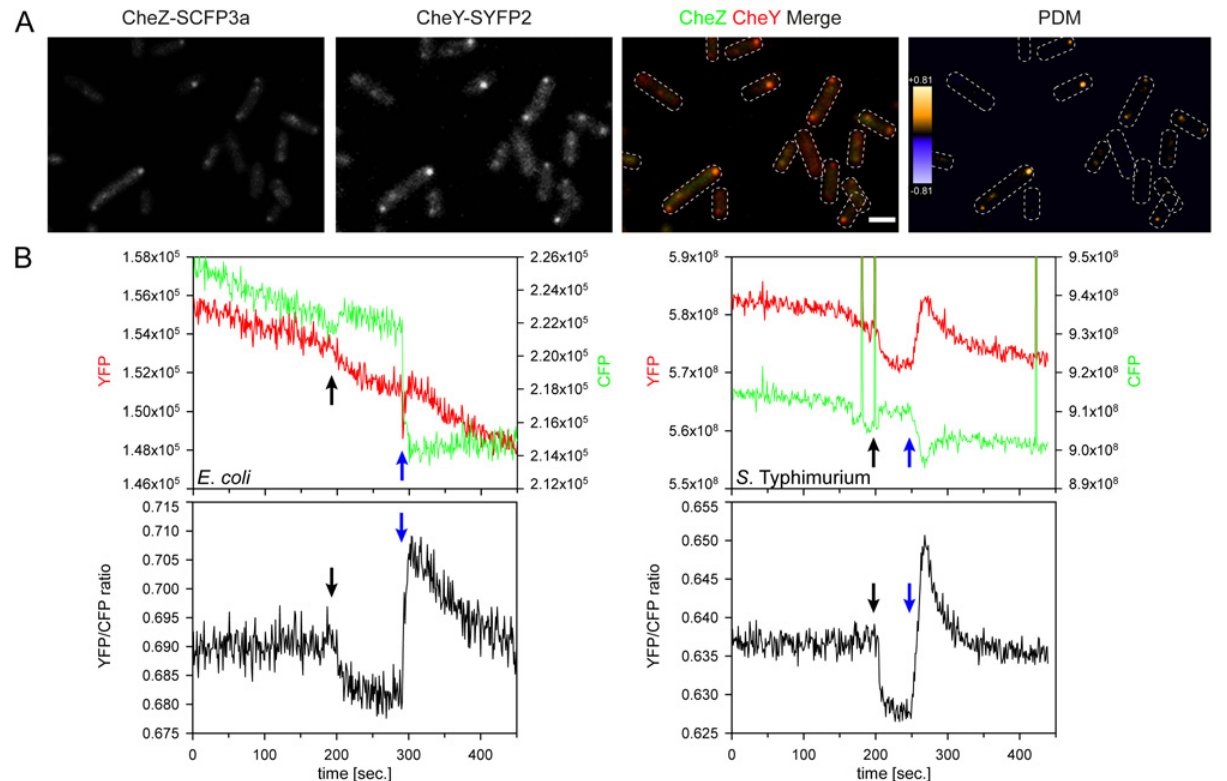
Fig 6. Localization and interaction of chemotaxis proteins CheY and CheZ. (A) Fluorescence microscopy of S . Typhimurium MvP103 ( Δ sseC ) cells co- expressing CheY-SYFP2 and CheZ-SCFP3a fusion proteins from Expression clone pWRG415. Signals from CFP- and YFP channels are shown separately as well as merged and pseudo-colored as indicated. Both fusion proteins formed intense clusters at the poles of the bacterial cells. The product of the difference from the mean (PDM) of both channels was calculated and plotted to show sites of complex formation (orange). The shapes of individual bacteria were illustrated by dashed white lines. Scale bar = 1 μ m, Scale in PDM image = positive covariance (orange) and negative covariance (blue) (B) The same Expression clone as in (A) was used to detect the dynamics of the CheY-Z interaction by FRET in E . coli VS104 [ Δ ( cheY-cheZ )] (left) and S . Typhimurium MvP103 (right) cells. The fluorescence intensities of the CFP (green) and YFP (red) channels are depicted in the upper graphs. The YFP/CFP ratios calculated from the fluorescence intensities are shown below. Addition (black arrows) and removal (blue arrows) of the chemotactic attractant MeAsp resulted in a decrease (no interaction) or increase (interaction) of the YFP/CFP quotient,